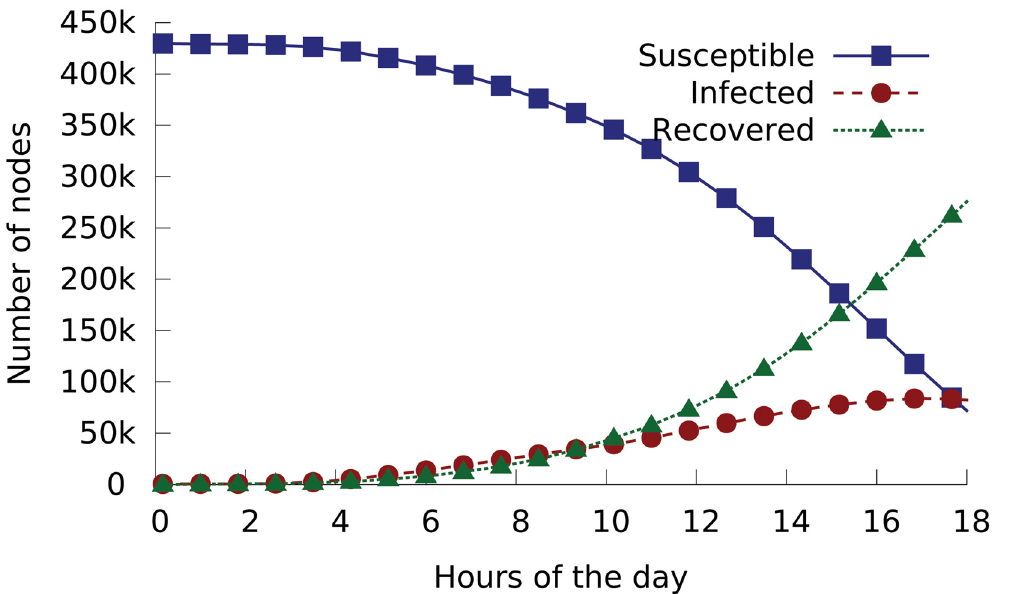
Fig 3. Numbers of susceptible nodes S ( t ), infected nodes I ( t ) and recovered nodes R ( t ) as a function of time t , as inferred from CAIDA ’ s dataset on 21/Nov/ 2008, the day of Conficker ’ s